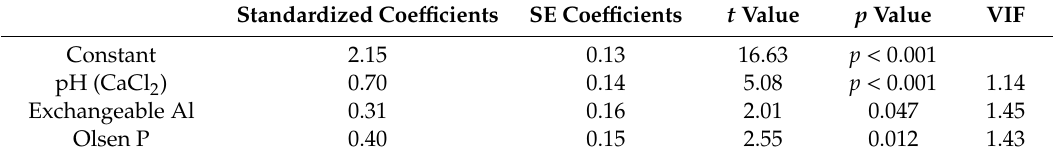
Table 3. Multiple linear analysis regression results (coded coe ffi